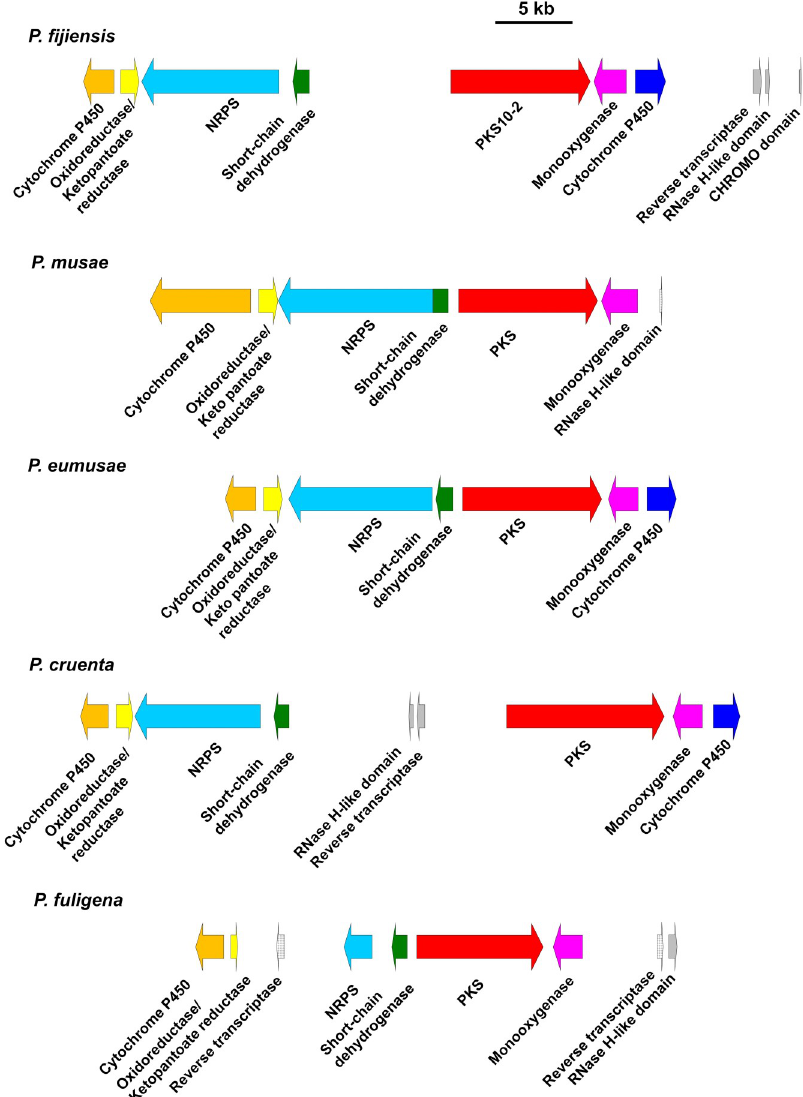
Fig 10. Comparison of PKS10-2 gene clusters from Pseudocercospora species. Putative biosynthetic clusters from P . fijiensis , P . musae , P . eumusae , P . cruenta , and P . fuligena are shown, with arrows indicating directionality for each gene. Putative orthologous genes are shown in the same color. Additional conserved domains identified in S5 Table are shown in gray arrows for specific hits and checkered arrows for non-specific hits. Scale bar represents 5 kb.